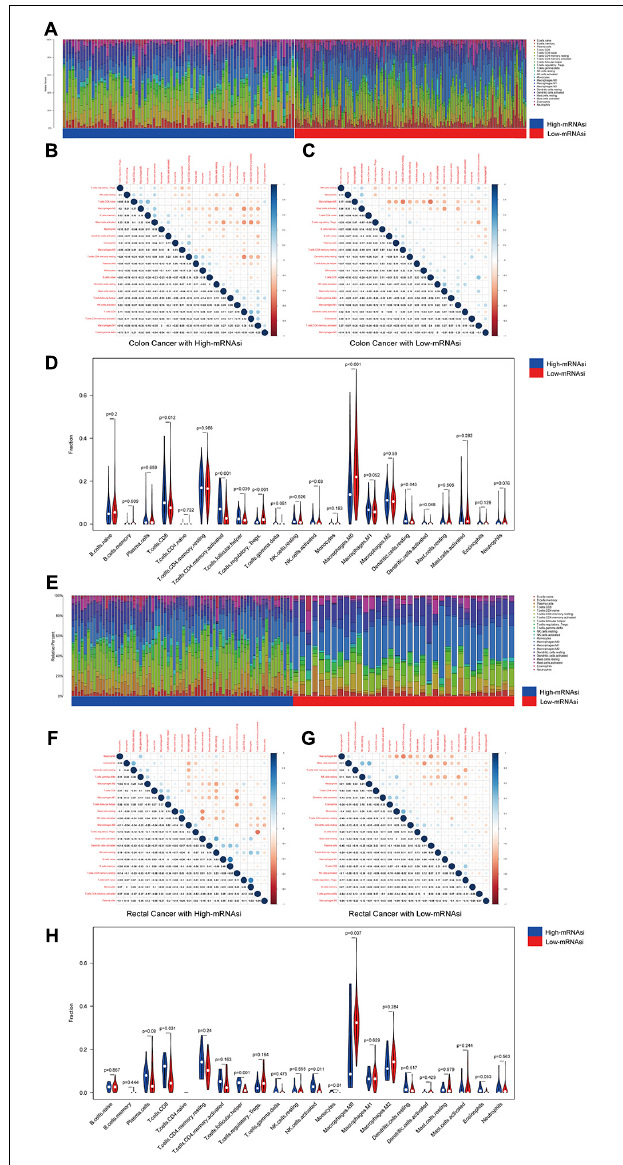
FIGURE 3 | Composition of immune cells in different mRNAsi groups and correlation analysis. (A) Barplot showing the fractions of 22 immune cells of colon cancer patients in the TCGA-COAD database. Column names of the plot were the sample ID. (B) Heatmap showing the correlation between immune cells of colon cancer cases in the high-mRNAsi group. (C) Heatmap showing the correlation between immune cells of colon cancer cases in the low-mRNAsi group. The shade of each tiny color box represented the corresponding correlation value between two cells. (D) Comparison of the proportions of immune cell subsets between different mRNAsi groups of colon cancer. ANOVA test, p -values are shown. (E) Barplot showing the fractions of 22 immune cells of rectal cancer patients in the TCGA-READ database. Column names of the plot were the sample ID. (F) Heatmap showing the correlation between immune cells of rectal cancer cases in the high-mRNAsi group. (G) Heatmap showing the correlation between immune cells of rectal cancer cases in the low-mRNAsi group. The shade of each tiny color box represented the corresponding correlation value between two cells. (H) Comparison of the proportions of immune cell subsets between different mRNAsi groups of rectal cancer. ANOVA test, p -values are